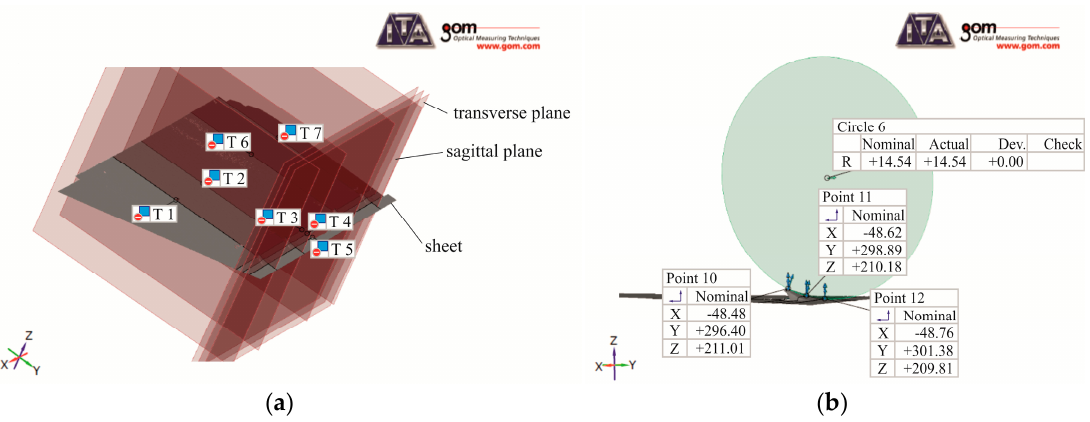
Figure 6. ( a ) Example of positioning base surfaces in the measuring system and ( b ) the principle of bending radius measurement.